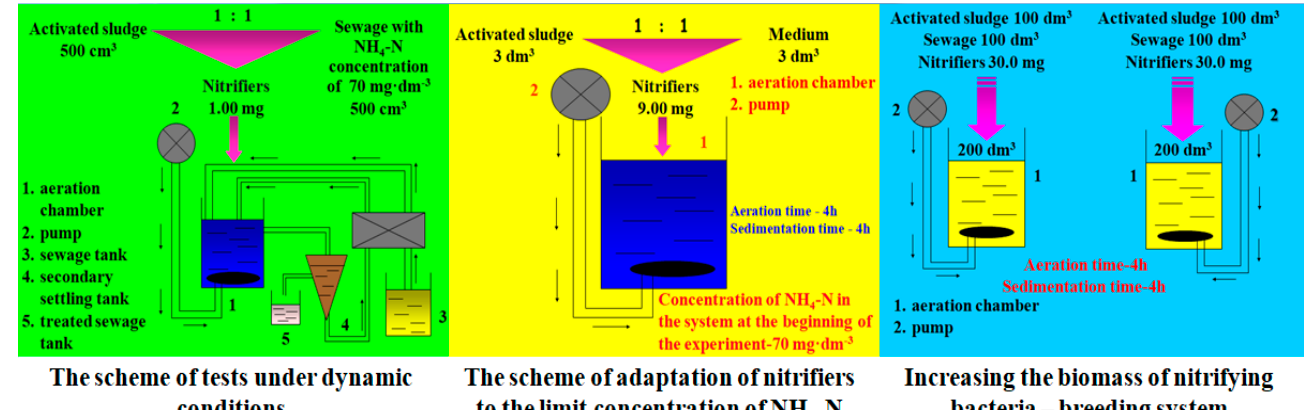
Figure 1. Schemes of conducted experiments.